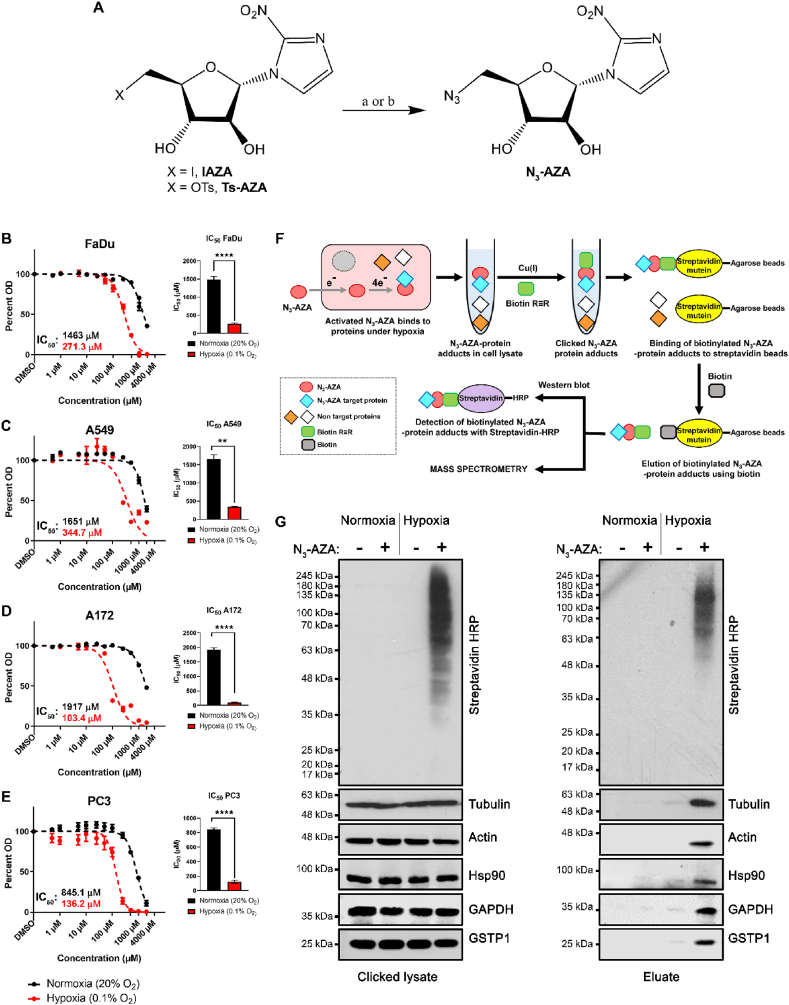
N3-AZA synthesis, cytotoxicity and click chemistry principle to isolate 2-NI target proteins. (A) Synthesis of N3-AZA. Reagents and conditions: (a) Ts-AZA, NaN3, DMSO, 50 °C, overnight, 69%; (b) IAZA, NaN3, DMF, 100 °C, 2 h, 93%. N3-AZA shows preferential cytotoxicity in hypoxic FaDu (B), A549 (C), A172 (D) and PC3 cells (E), with statistically significant differences between their normoxic and hypoxic IC50 values. Data represents mean ± S.E.M. from at least three independent experiments. (F) Experimental design for isolation and visualization of N3-AZA bound proteins. (G) Click chemistry was performed on cell extracts collected from N3-AZA (or DMSO) treated normoxic and hypoxic FaDu cells using a biotin alkyne. Western blotting showed that the signal for Streptavidin-HRP is only present in drug treated hypoxic samples. Drug bound proteins could successfully be isolated using streptavidin-mutein beads, with no significant background binding. Representative immunoblots are displayed from three independent experiments.